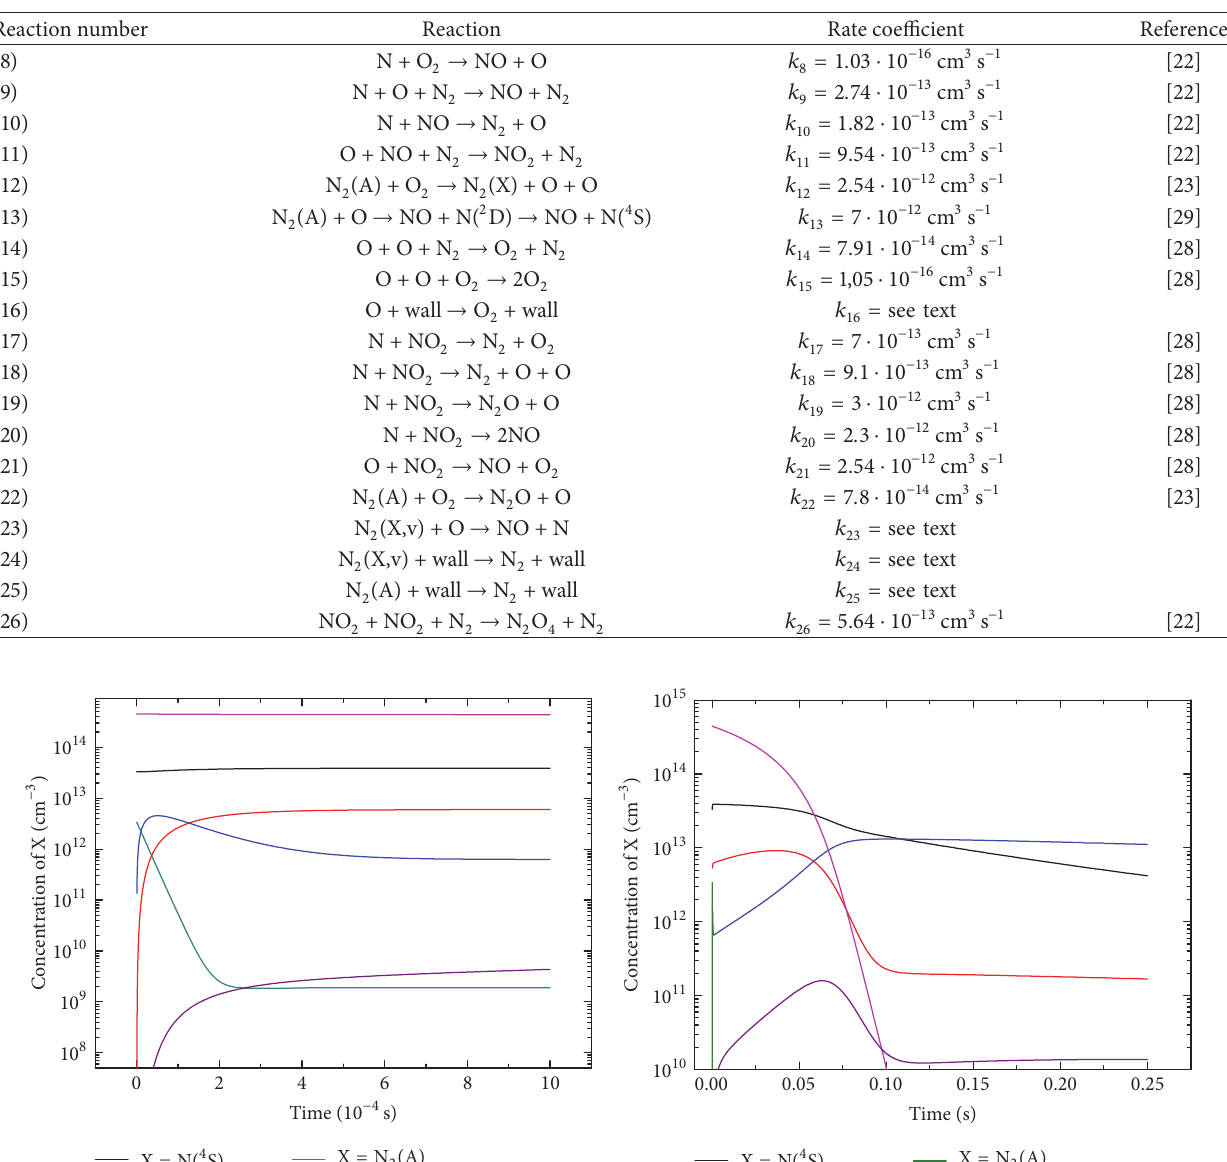
Table 2: Additional set of kinetic reactions for nitrogen afterglow with oxygen admixture, mostly based on [28].